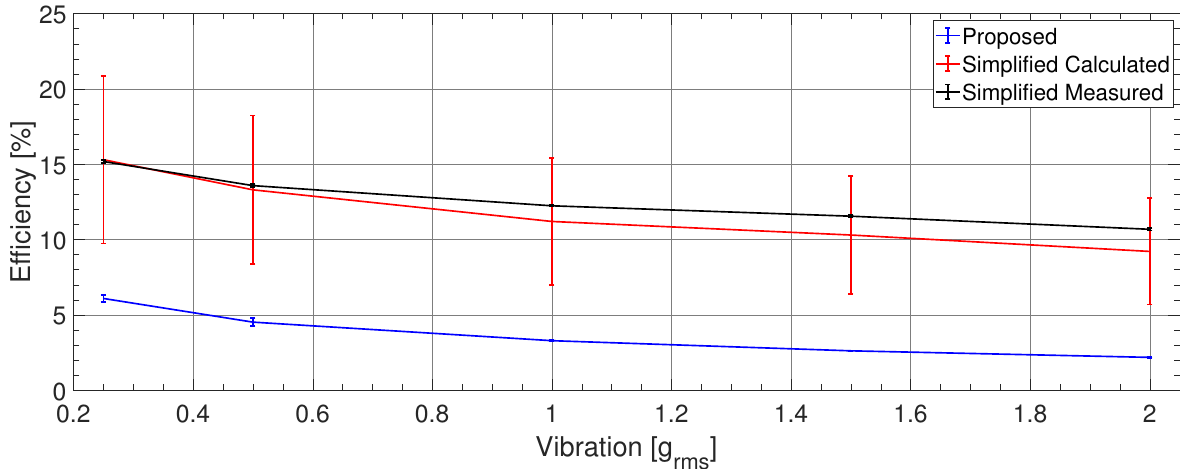
Figure 7. The PZT PEH: Comparing the efficiency values established via our method (proposed) with those calculated from the PEH’s parameters for the optimum condition (simplified calculated) and measured from the PEH’s mechanical power (simplified measured). The error bars represent the 1 σ interval.